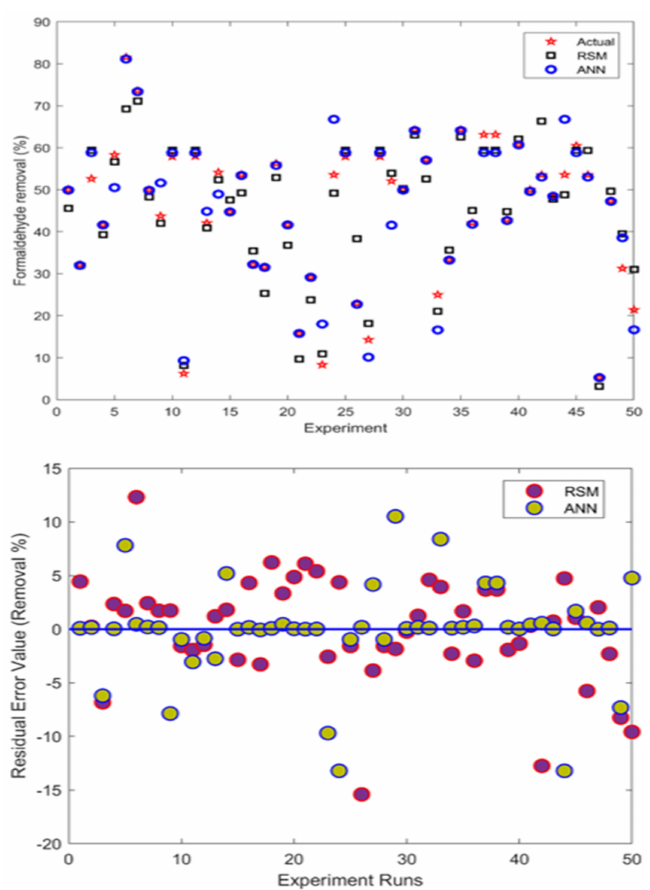
Figure 4. Comparison of the residual errors, along with the actual and predicted values of the formaldehyde removal efficiency by the ANN and RSM